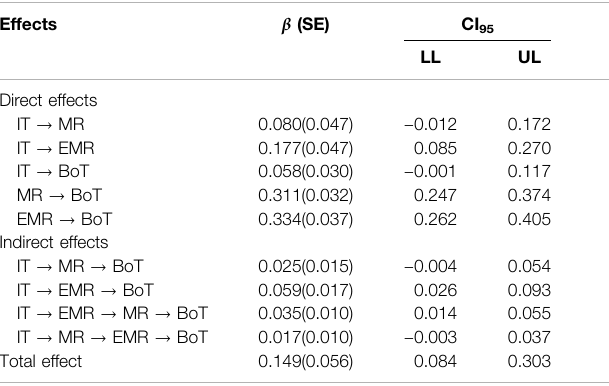
TABLE4| Standardizedcoef fi cients,standarderrors,andcon fi denceintervalsfor direct, indirect, and total effects for structural equation model.